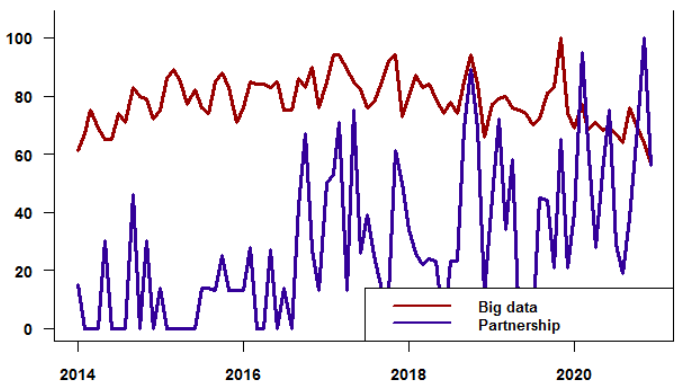
Figure 18. Big Data and SDG 17 global Google trends since